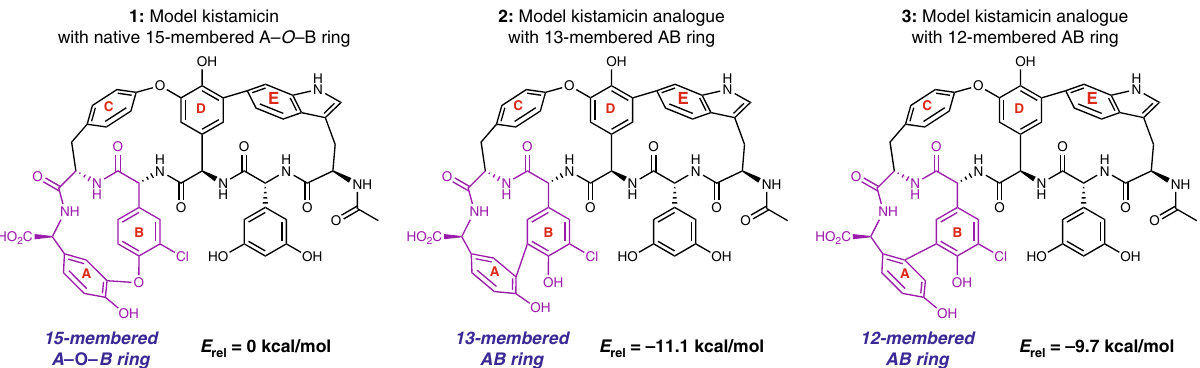
Fig. 3 Computational analysis of alternative A-B ring crosslinks. Comparison of the relative energies of kistamicin (containing the native 15-membered A- O - B ring and modelled as 1 ) relative to the energies of kistamicin analogues 2 and 3 which contain 13- and 12-membered AB rings, respectively. The ring derived from A- O -B crosslinking is signi fi cantly less stable than the smaller rings derived from AB crosslinking. Source data are provided as a